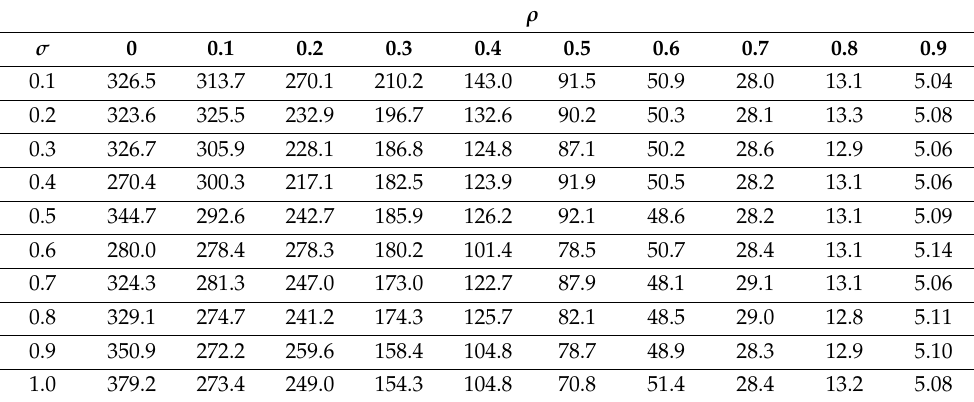
Table 2. Average run length by ρ and σ for the Clayton